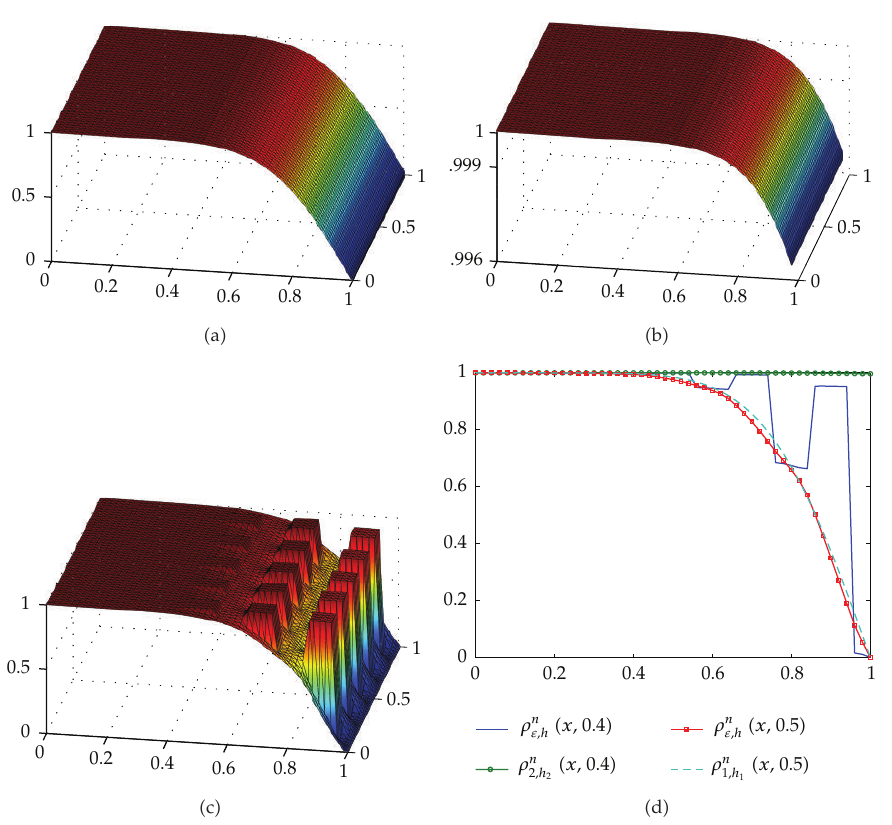
Figure 2: Numerical approximation at t n (cid:7) 3 × 10 − 2 of (cid:8) a (cid:9) - (cid:8) b (cid:9) the solutions of the two components of the macro-model (cid:8) 4.2 (cid:9) , and (cid:8) c (cid:9) the solutions of the micro-model (cid:8) 2.8a (cid:9) and (cid:8) 2.8b (cid:9) . Figure (cid:8) d (cid:9) shows the side view of (cid:8) a, b, c (cid:9) at y (cid:7) 0 . 4 and y (cid:7) 0 . 5. Data from Example 3.1 with 1 /ε (cid:7) 5 and h (cid:7) h 1 (cid:7) h 2 (cid:7) 1 / 50. Note that (cid:8) a (cid:9) and (cid:8) b (cid:9) have di ff erent vertical